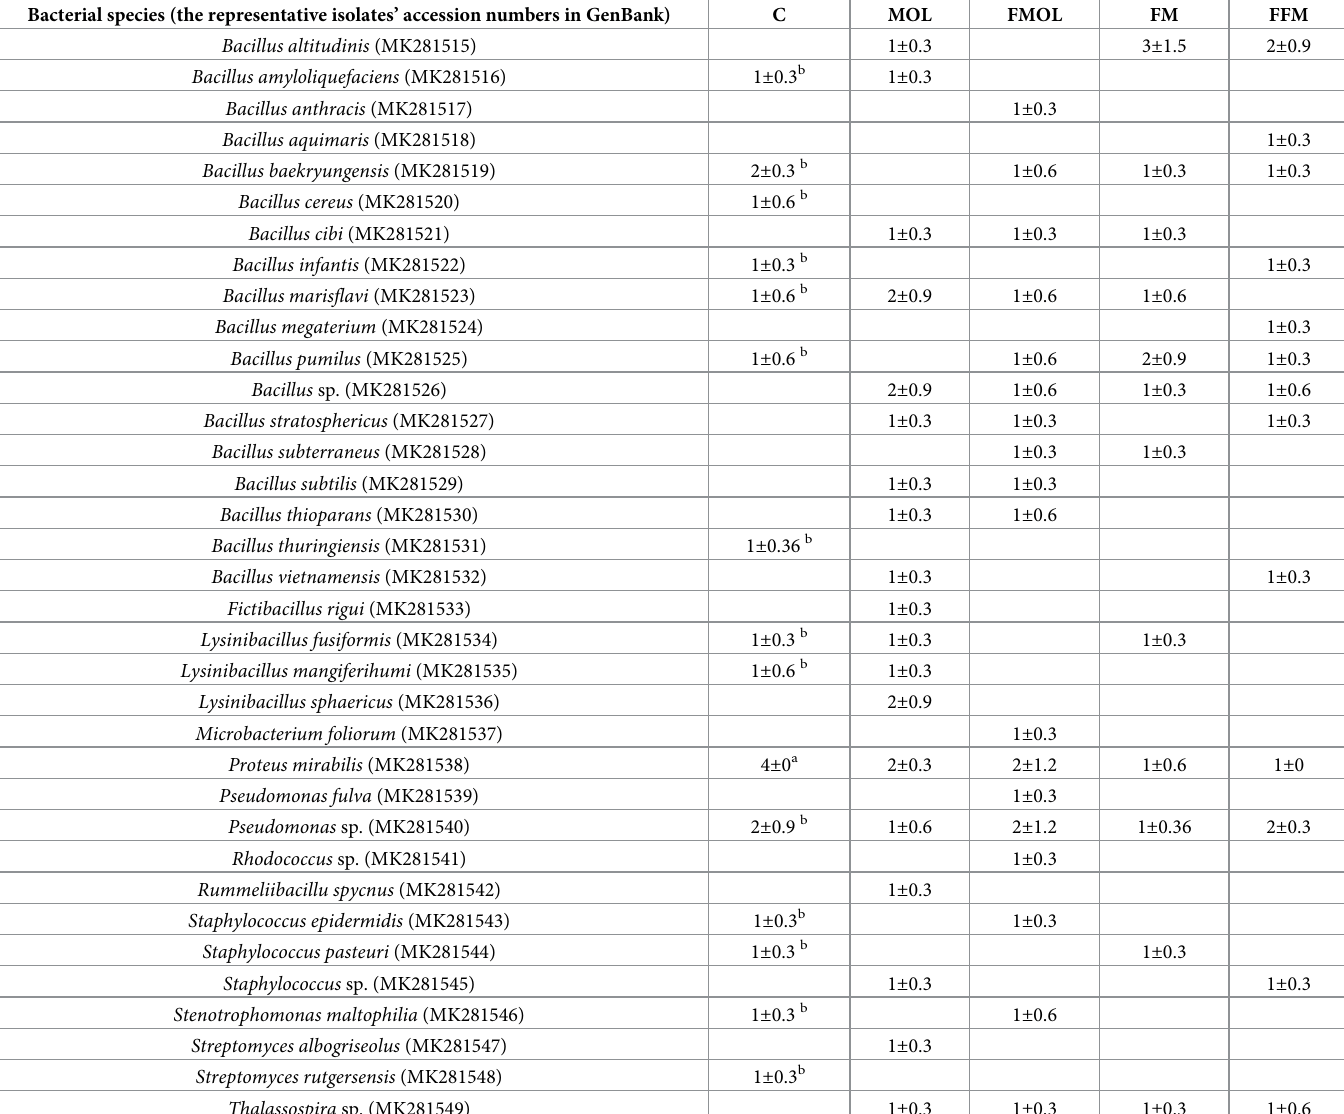
Table 3. Bacteria in the gut in five experimental groups. Bacterial species (the representative isolates’ accession numbers in GenBank)